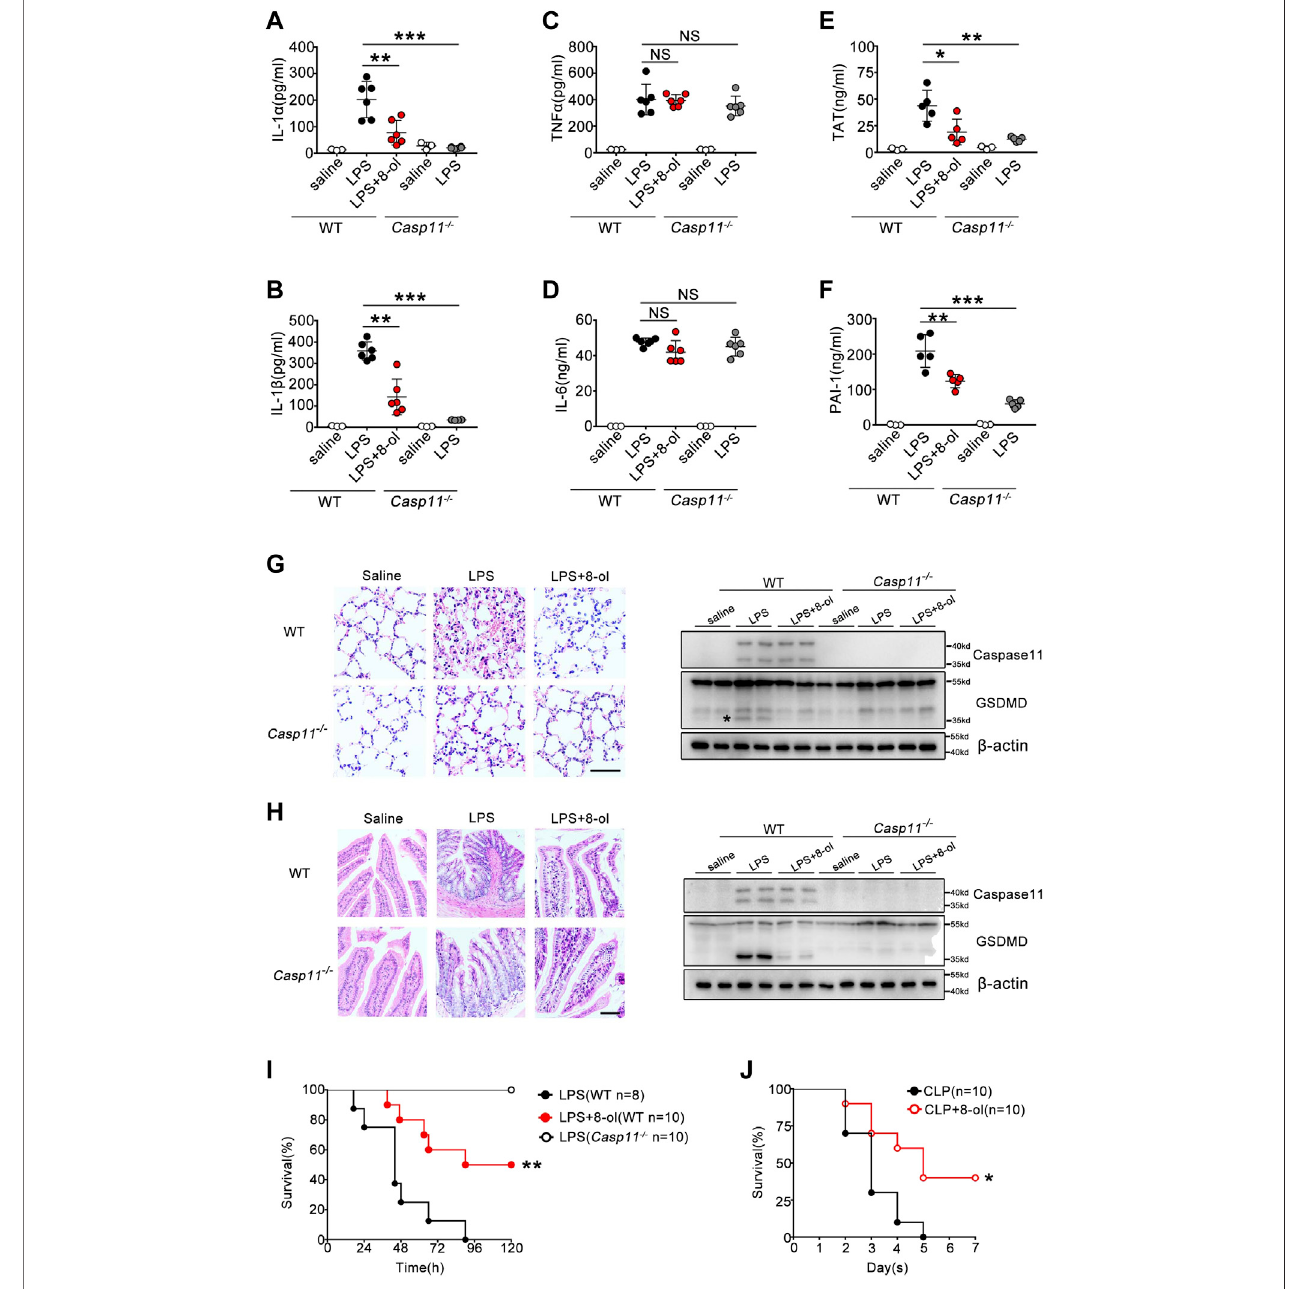
FIGURE6| 8-olinhibits caspase-11 – mediatedimmuneresponses invivo . (A – D) IL-1 α ,IL-1 β ,TNF α ,andIL-6release intheserum wasmeasured byELISA.WT or Casp11 − / − mice were pretreated with 8-ol (4 mg/kg) by intraperitoneal injection 30 min before being intraperitoneally challenged with LPS (20 mg/kg). (E,F) Plasma concentrationsofTATcomplexesandPAI-1weremeasuredat16 hinmiceinjectedwithLPS(20 mg/kg)withorwithout4 mg/kg8-oladministration. (G,H) H&Estaining shows representative images of lung and intestine tissues of endotoxemic WT or Casp11 − / − mice (left panel). Scar bar: 50 μ m. Western blots for the cleavage of GSDMDandtheexpressionofcaspase-11inthelungandintestine.WTor Casp11 − / − micewerepretreatedwith8-ol(4 mg/kg)byintraperitonealinjection30 minbefore being intraperitoneally challenged with LPS (20 mg/kg). “ * ” : GSDMD cleavage. (I,J) WT or Casp11 − / − mice were pretreated with 8-ol (4 mg/kg) 30 min before being intraperitoneally challenged with LPS (20 mg/kg) or subjected to cecum ligation and puncture (CLP) 1 h after 8-ol (4 mg/kg) treatment. Survival rates were shown by Kaplan – Meier survival curves. Circles represent individual mice. * p < 0.05; ** p < 0.01; *** p < 0.001; NS: not signi fi cant (Student ’ s t test and log-rank test for survival).